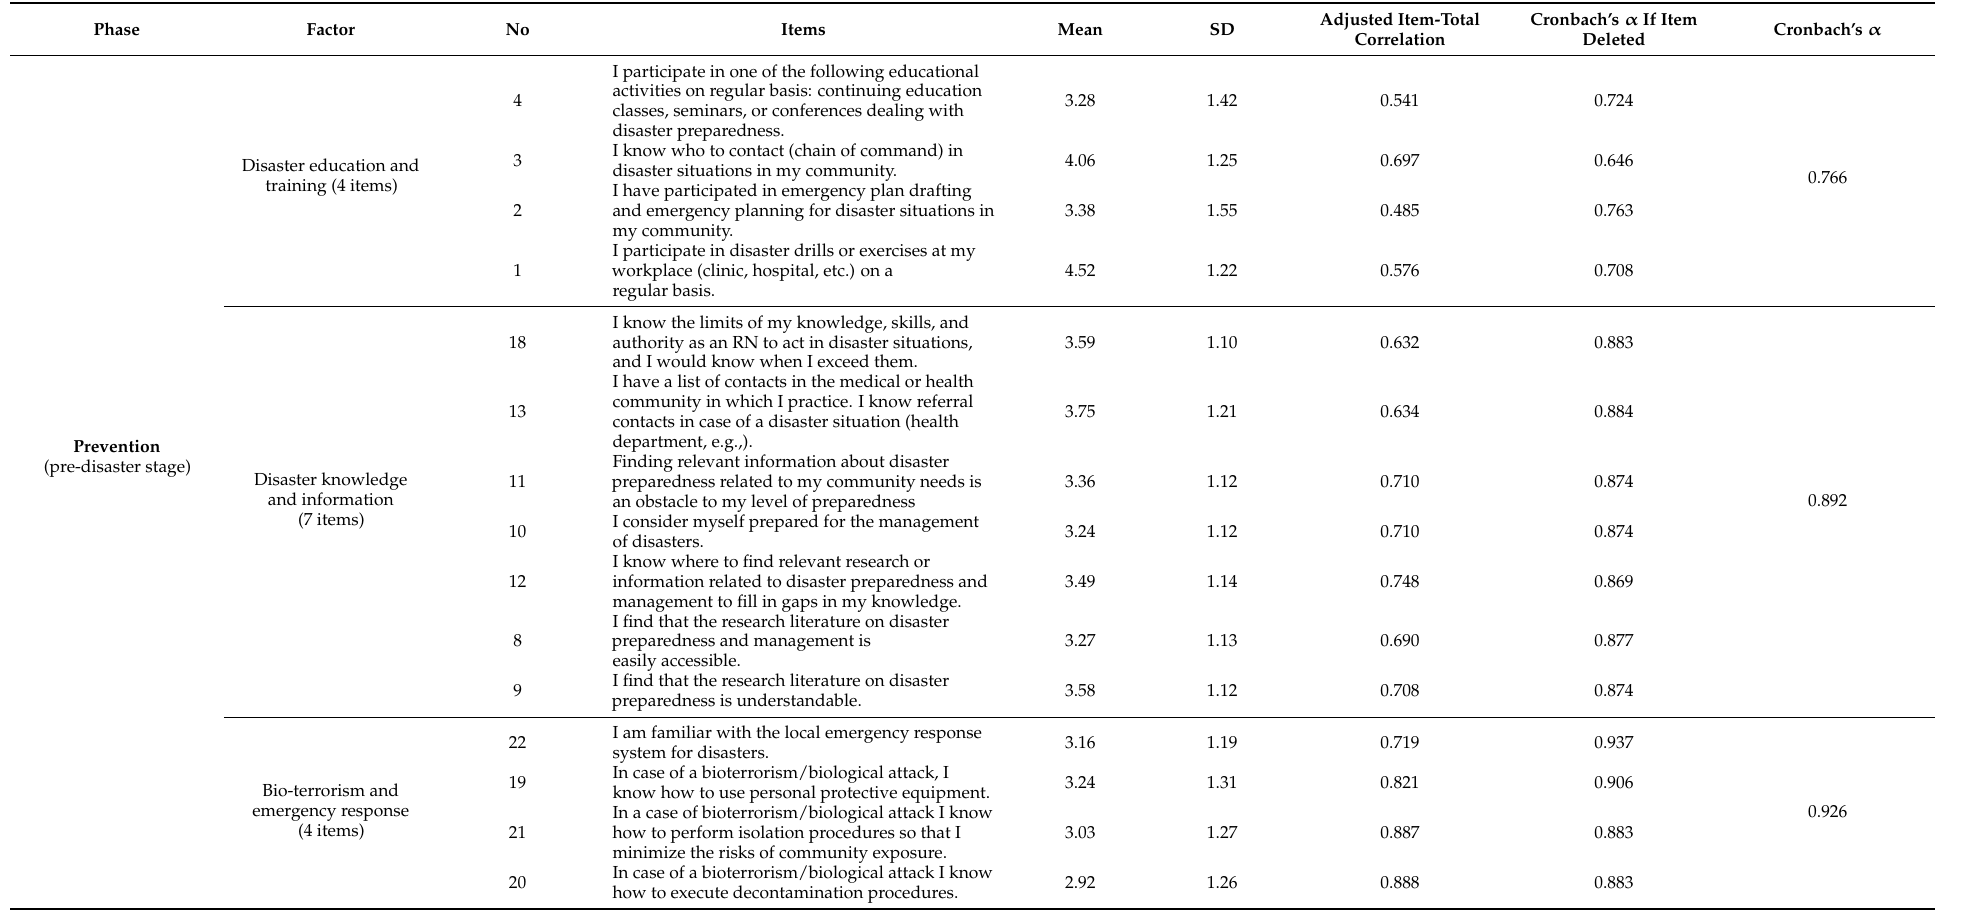
Table 6. Final item analysis by factor ( N =